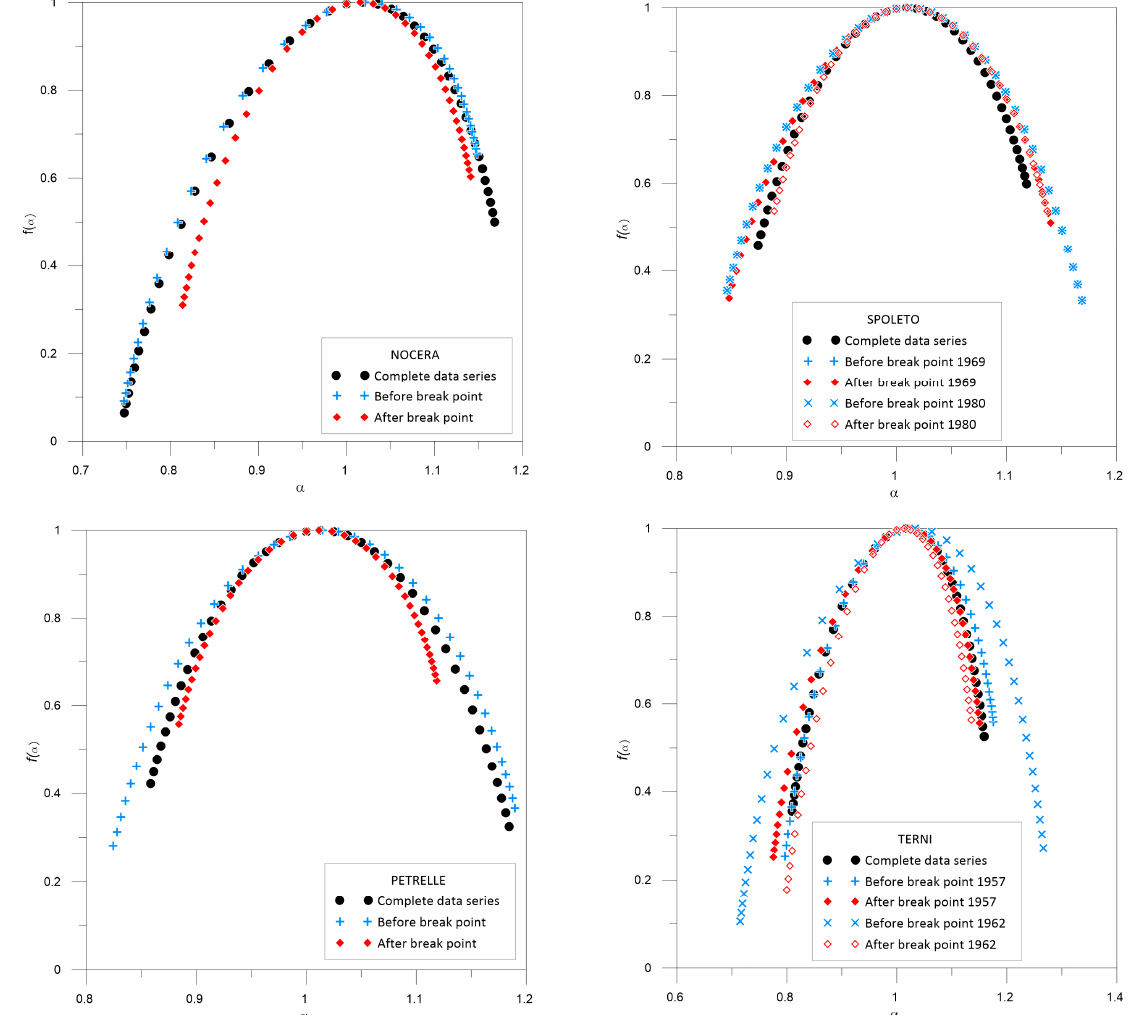
Figure 6. Multifractal spectra f( α ) for the complete rainfall data series and also for the rainfall data series before and after the break points detected in the Nocera Umbra, Petrelle, Spoleto and Terni stations.